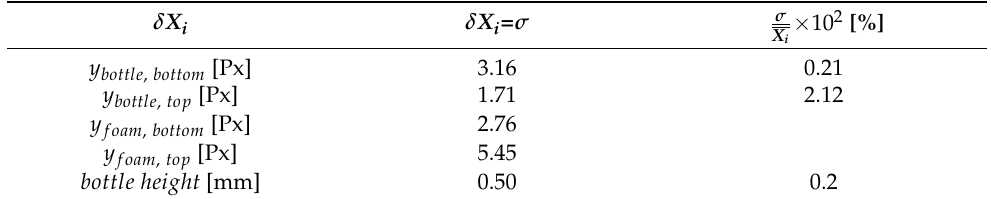
Table 4. Uncertainties dX i and the relative uncertainties σ given in the respective units, n = 40.